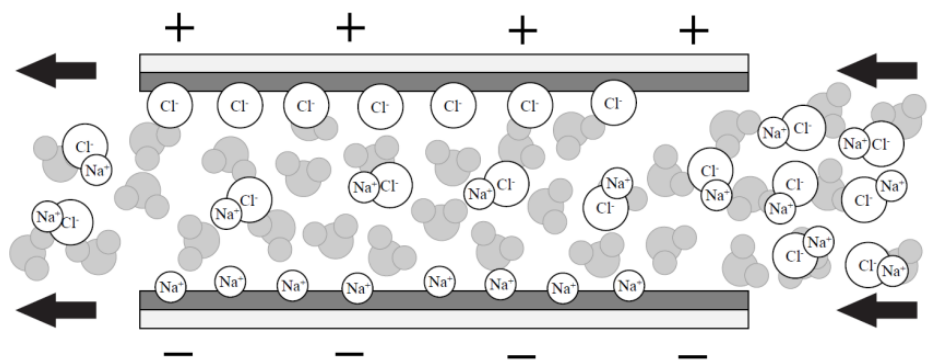
Figure 1. Ion adsorption during polarization of the